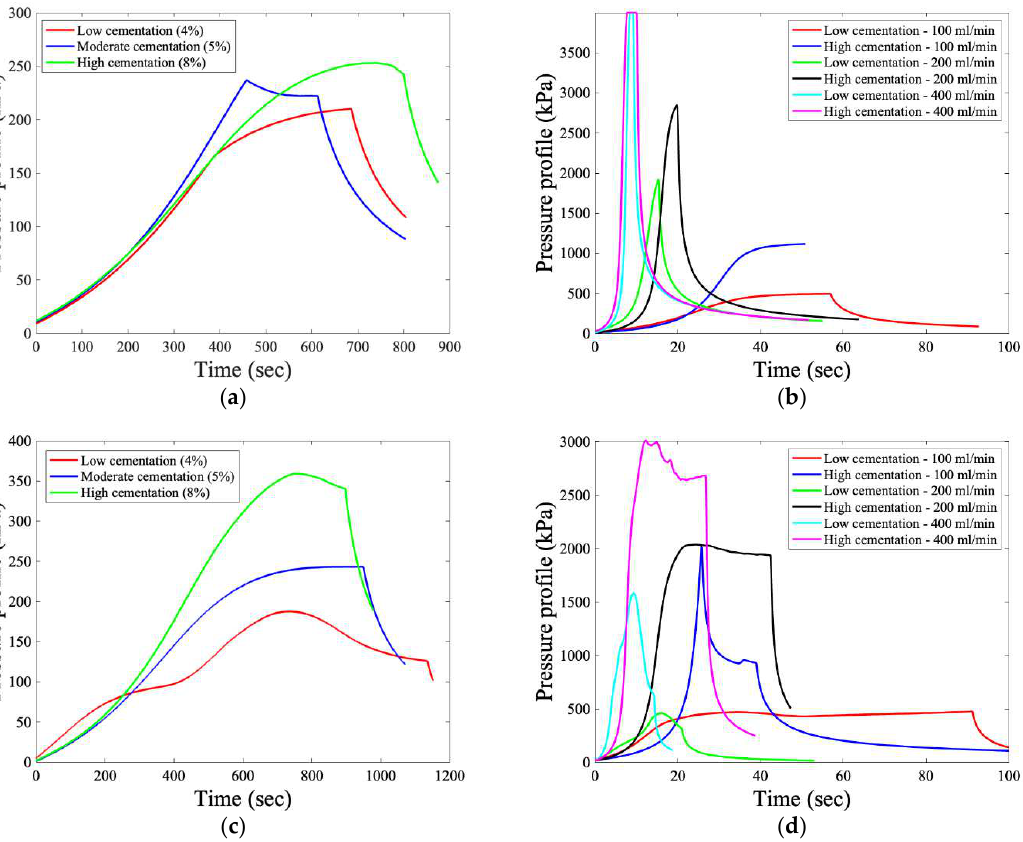
Figure 6. The pressure profiles obtained during glycerine injection experiments for: ( a ) bio-cemented glass beads at three cementation levels at 30 mL/min, ( b ) bio-cemented glass beads at the lowest and highest cementation levels at flow rates of 100, 200, and 300 mL/min, ( c ) bio-cemented medium-grained sands at three cementation levels at 30 mL/min, and ( d ) bio-cemented medium-grained sands at the lowest and highest cementation levels at flow rates of 100, 200, and 300 mL/min. Fluid injection experiments were conducted with bio-cemented sands with coarse and very coarse grains in order to further examine the effects of hydraulic conductivity and porosity variations and achieve different combinations of strength and hydraulic con- ductivity. Bio-cemented coarse sands had smaller strengths compared to the bio-ce- mented specimens generated from medium-grained sands but had similar strengths com- pared to bio-cemented specimens of fine sands and higher hydraulic conductivity and final porosity. The specimens generated with very coarse particles as the base material had the lowest strength across all sands examined in this study in the range of cementation levels achieved. Figure 7a shows the tests conducted on medium-sized grains with varying cementa- tion levels at a flow rate of 30 mL/min. The fractures were crack-like and less visible with the naked eye in this case, whilst the breakdown pressures (or initiation pressures, de- pending on whether a fracture was induced) fluctuated between 127 and 290 kPa. These values were lower compared to the fine sands shown previously falling in the range be- tween 169 and 698 kPa because of the higher hydraulic conductivity of coarse-sized grain sands. A significant amount of the injected fluid was flowing through the pores rather than increasing the pressure required to generate a fracture.